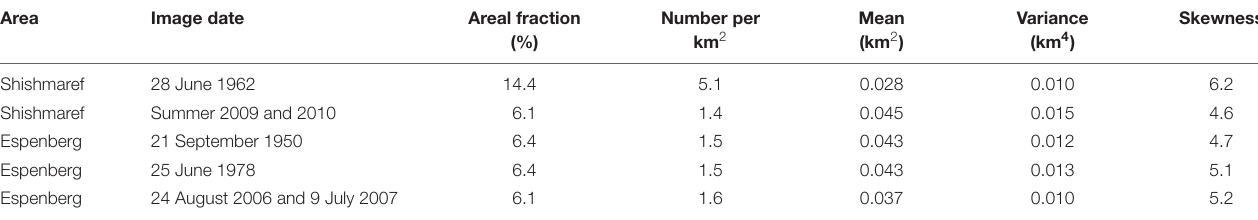
TABLE 4 | Statistics of waterbody size distributions over time for Shishmaref and Espenberg areas in the Kotzebue Sound Lowlands, Alaska. Area Image date Areal fraction (%)